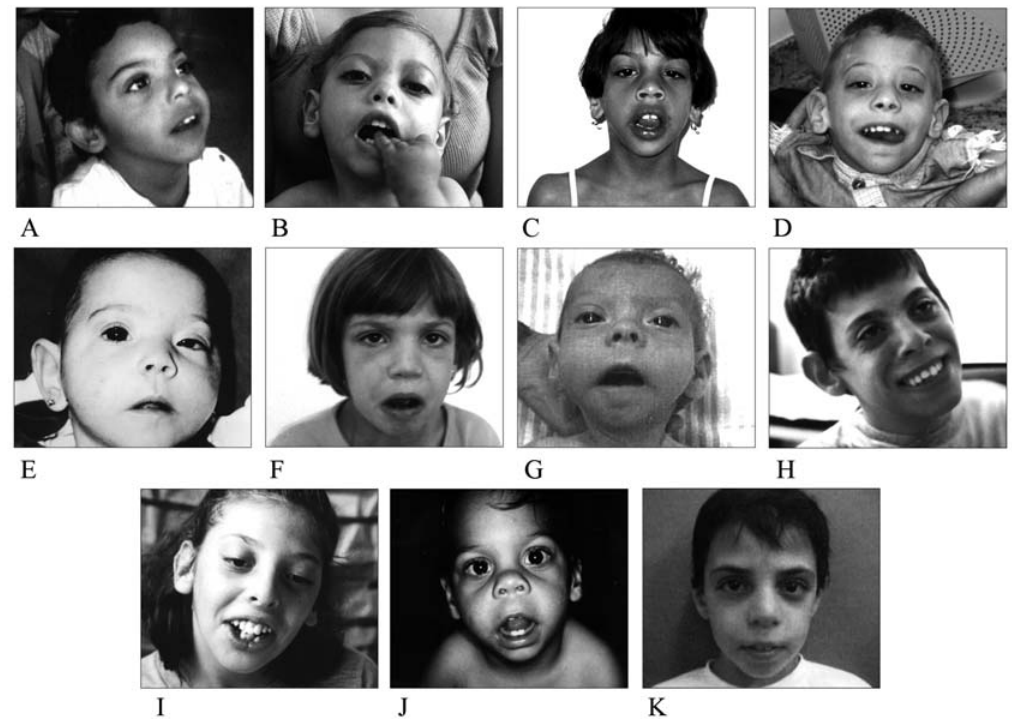
Figure 1 - Facial appearance of our confirmed cases of Smith-Lemli-Opitz syndrome (SLOS): (A) patient 1, (B) patient 2, (C) patient 3, (D) patient 4, (E) patient 5, (F) patient 6, (G) patient 7, (H) patient 8, (I) patient 9, (J) patient 10, (K) patient